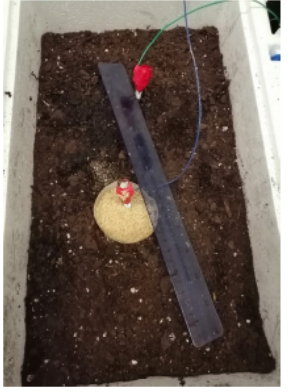
Figure 12. Case 2: The aluminum container filled with wood sawdust.